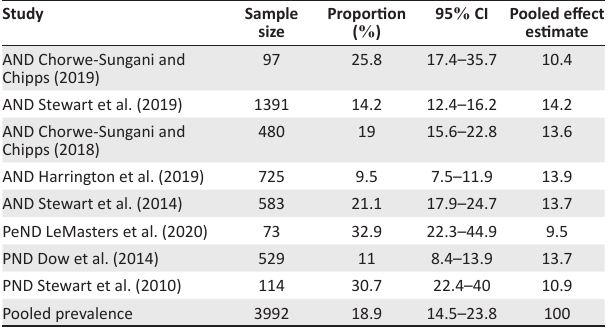
TABLE 6: Overall pooled prevalence of perinatal depression in Malawi. Study Sample